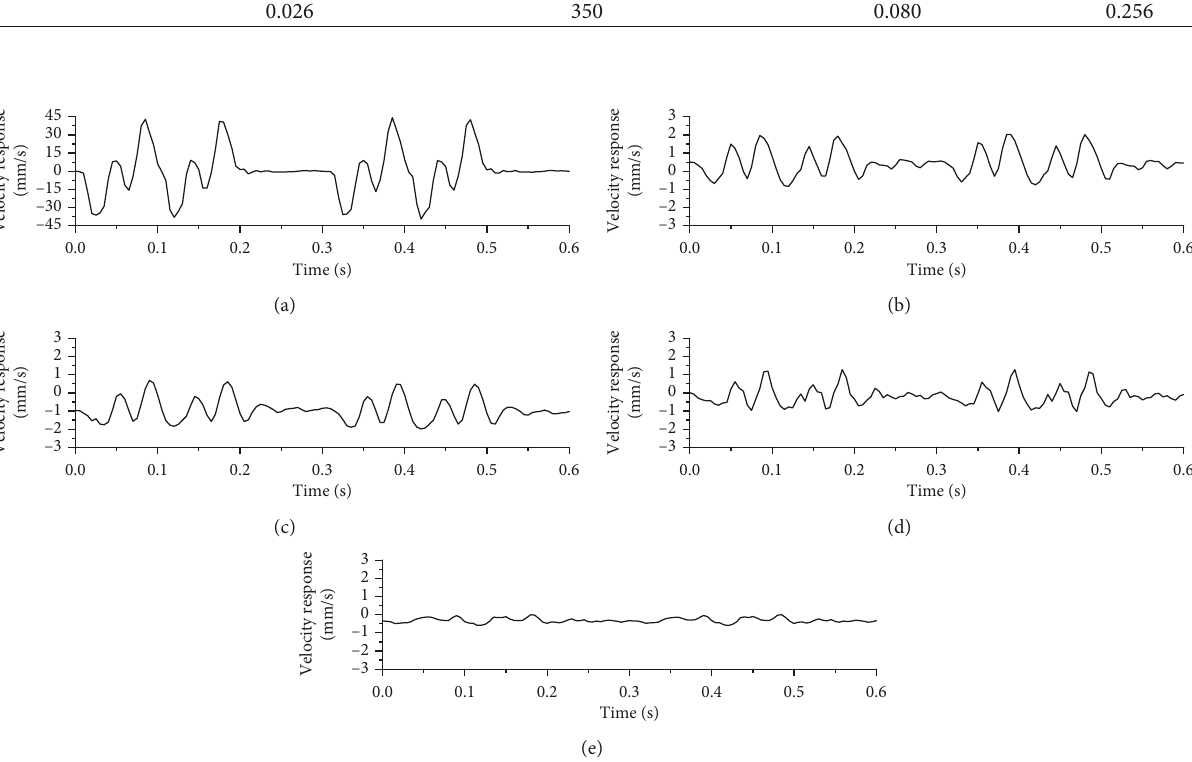
Figure 5: Vertical velocity with respect to time: (a) track slab; (b) surface layer of subgrade; (c) bottom layer of subgrade; (d) surface layer of foundation; (e) bottom layer of foundation.